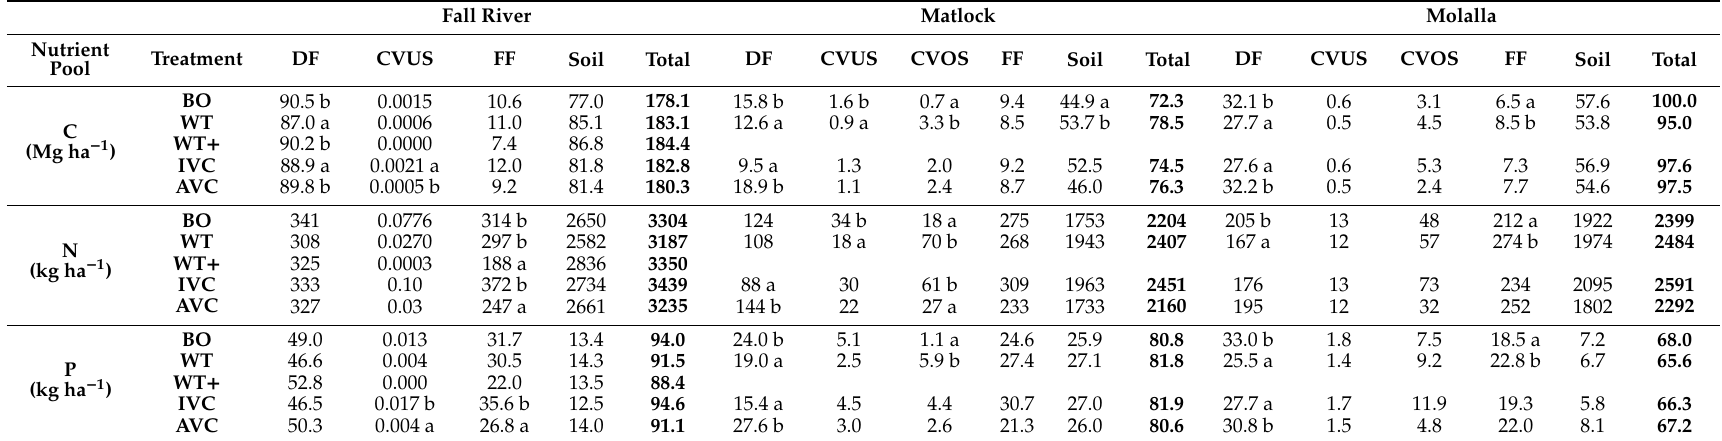
Table A1. Aboveground and belowground C, N, and P nutrient pools at Fall River, Matlock, and Molalla. Values with di ff erent lowercase letters are significantly di ff erent ( p < 0.10) among organic matter (BO, WT, WT + ) or vegetation control treatments (IVC,